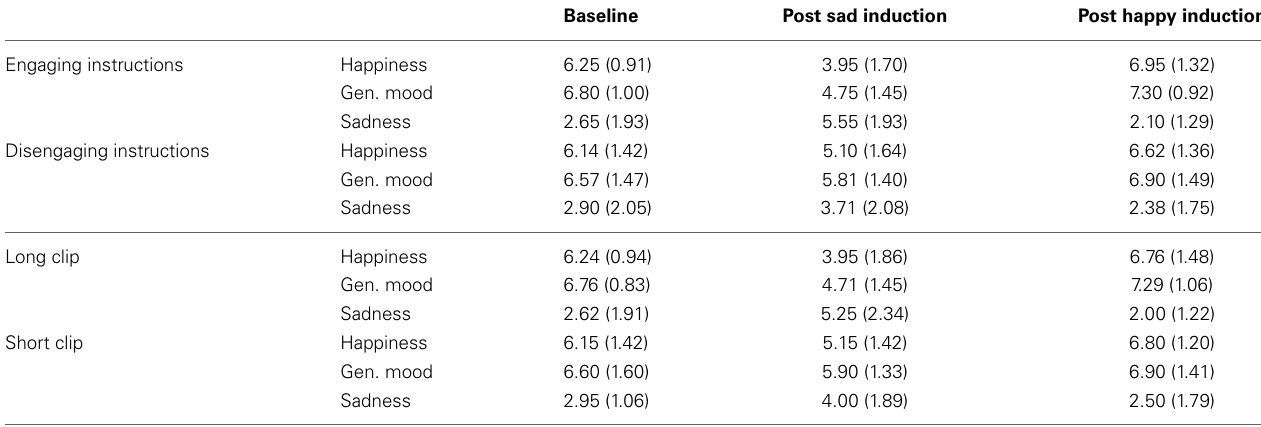
Table 1 | Means and SD ’s (in parenthesis) of self reported happiness, general mood, and sadness ratings in Study 1, in the different emotional engagement